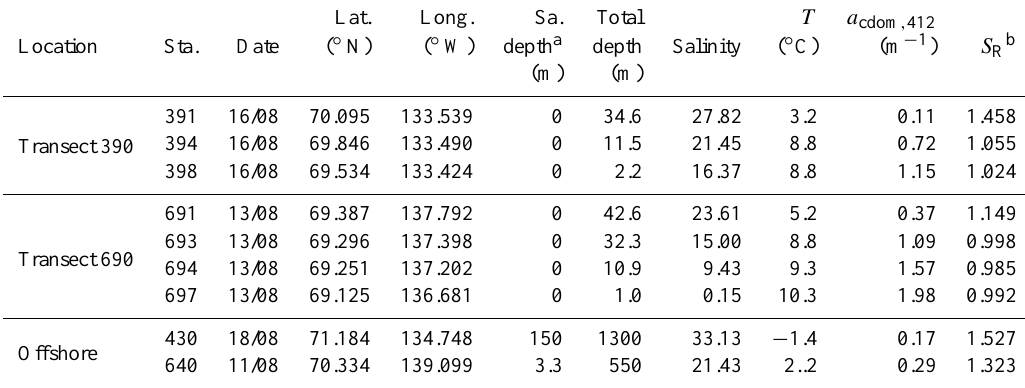
determinations. NH + 4